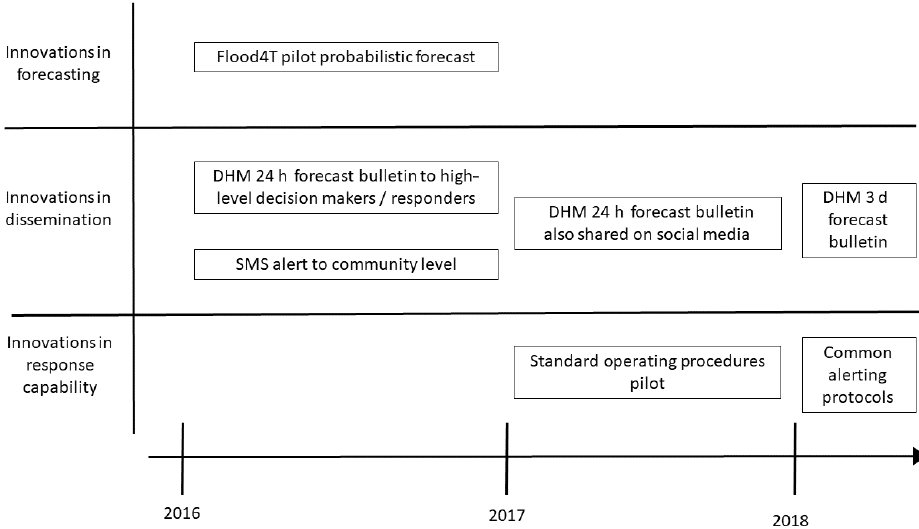
Figure 4. Timeline of recent developments and innovations in Nepal’s